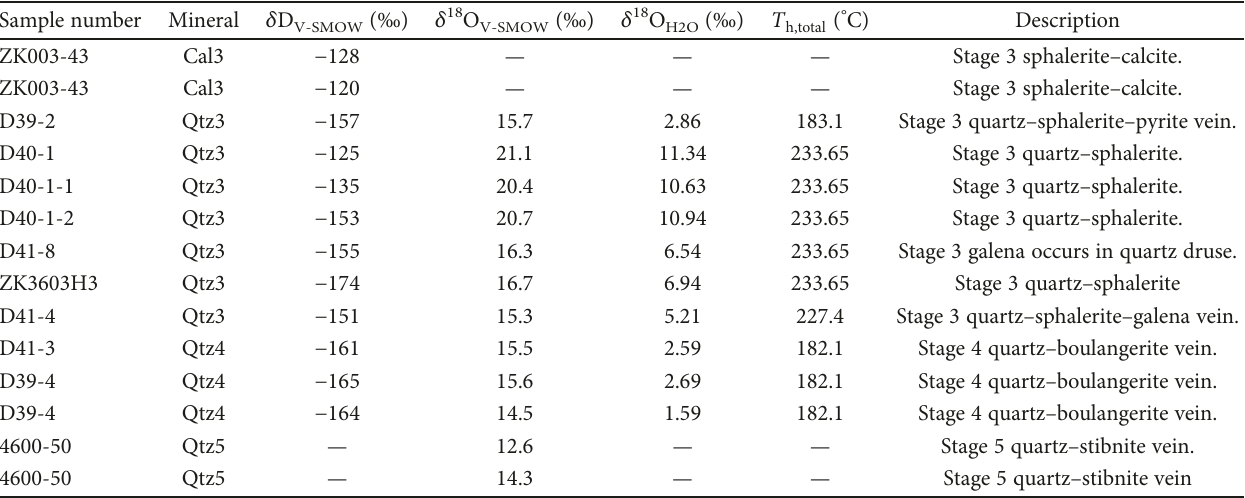
Table 3: The H – O isotopic data for minerals from the Keyue deposit.